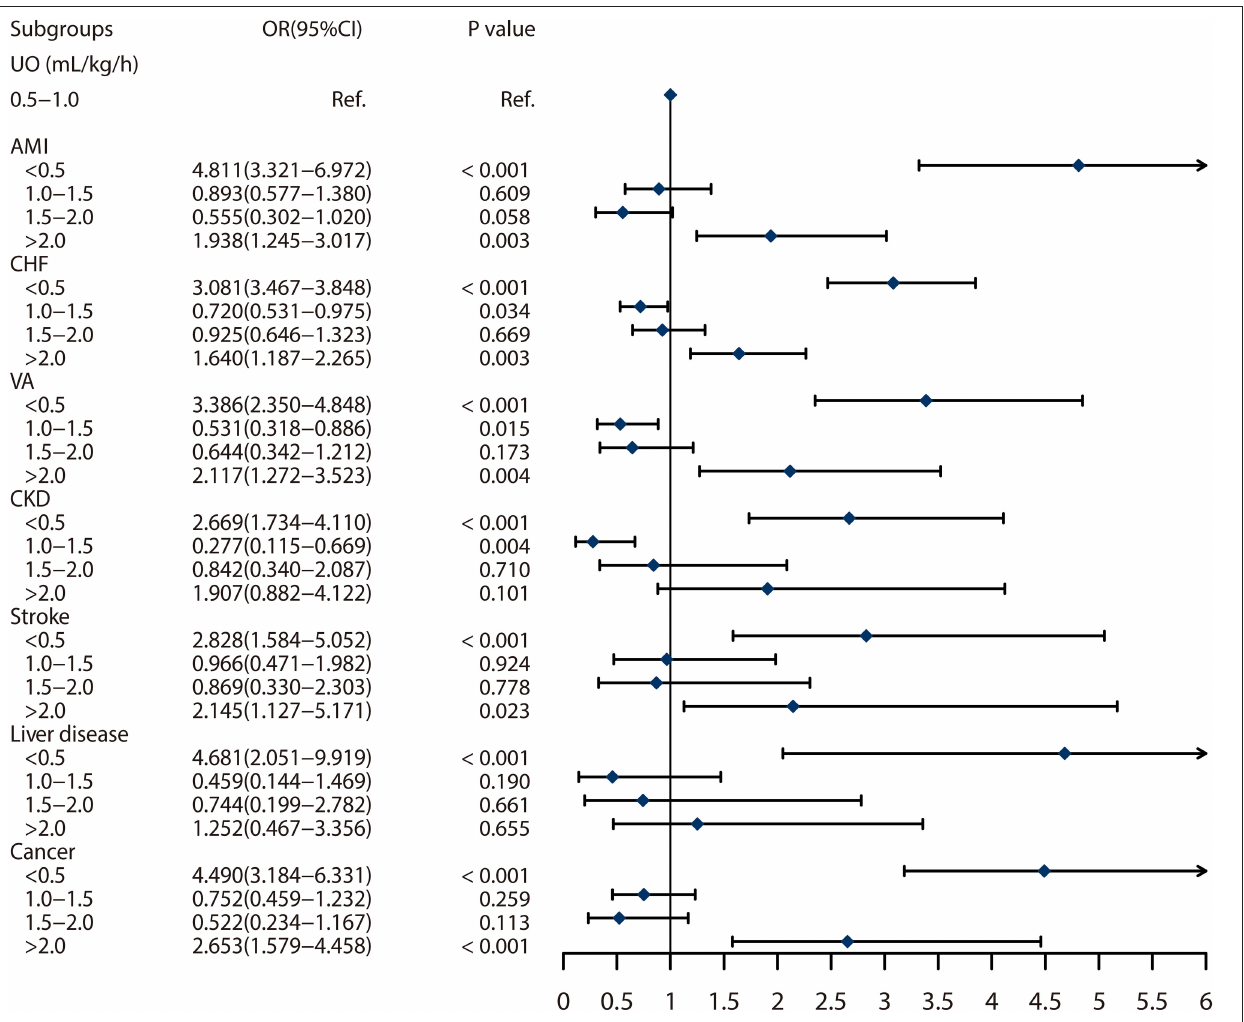
FIGURE 4 | Subgroup analyses on association between urine output and 30 days mortality based on the different comorbidities. The abbreviations are as same in Table 1 .